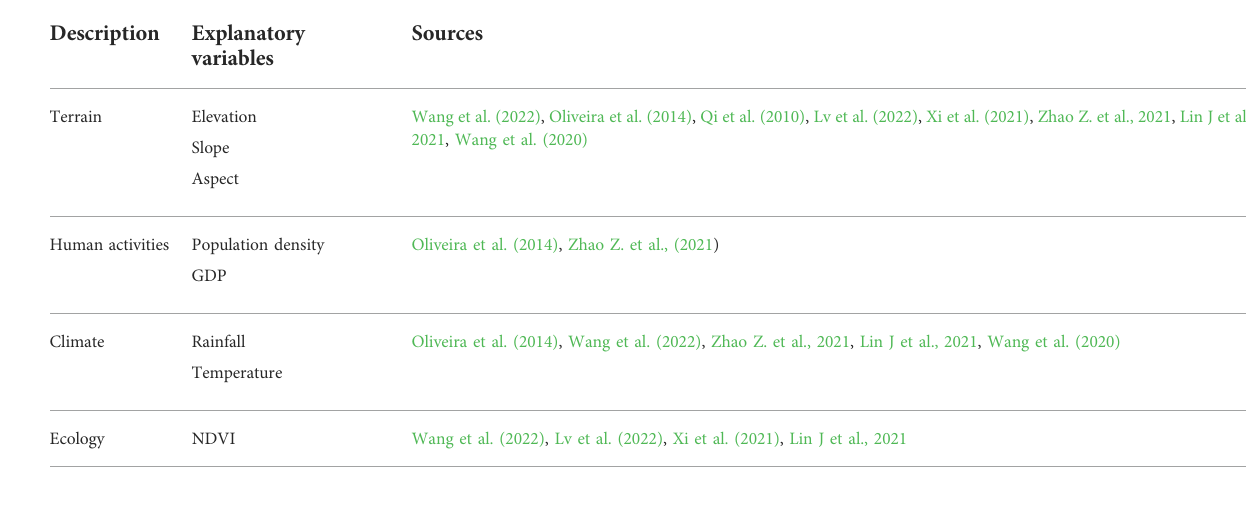
TABLE 1 Explanatory variables in the